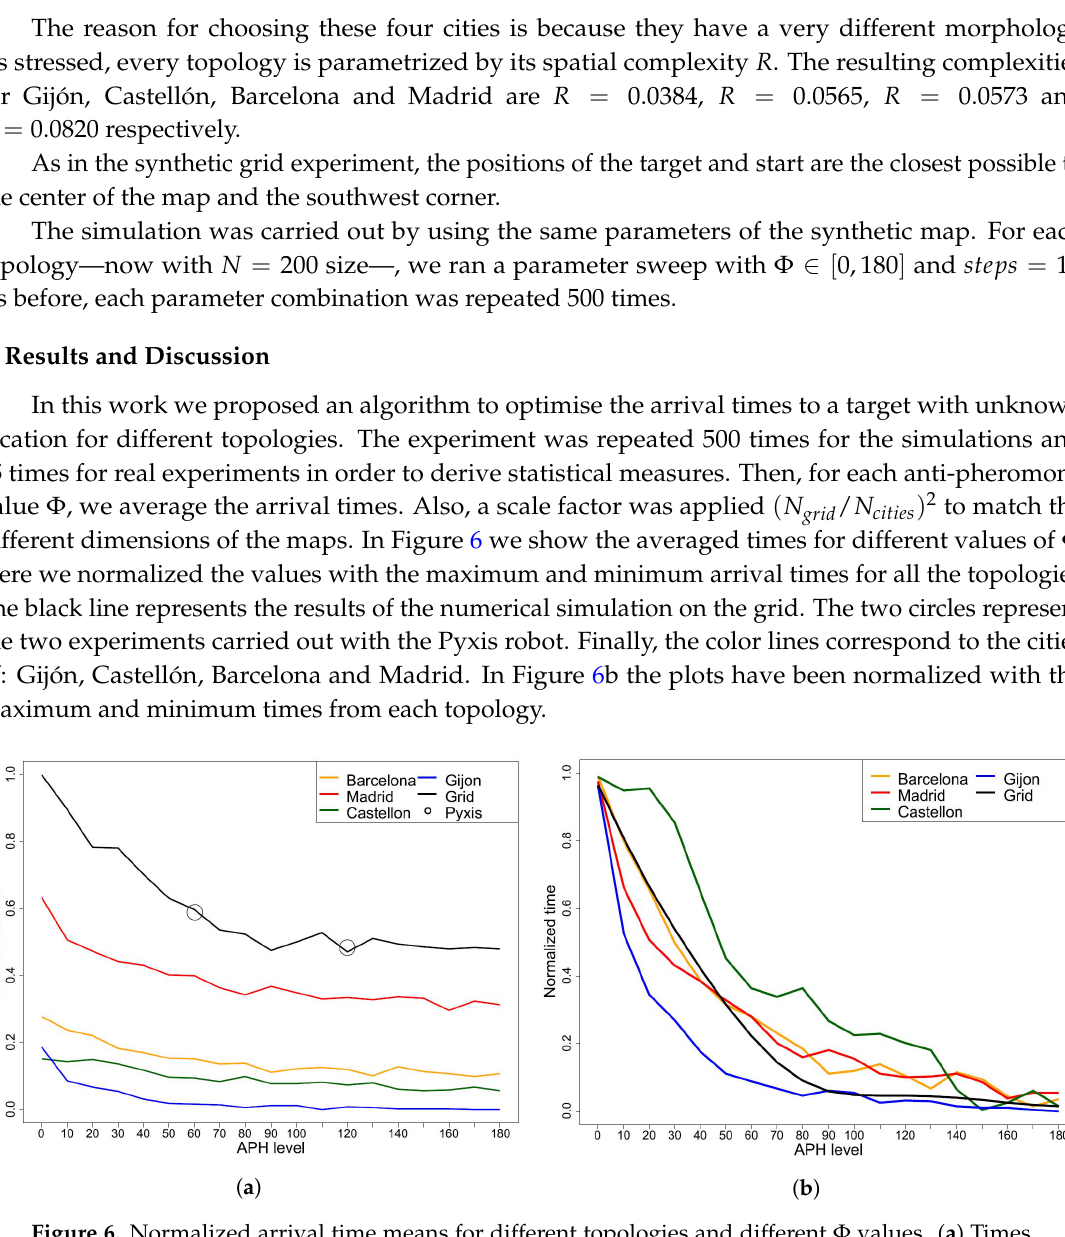
Figure 6. Normalized arrival time means for different topologies and different Φ values. ( a ) Times are first scaled with the city to grid area ratio and then normalized with the maximum and minimum values obtained from all topologies; ( b ) times are normalized with the maximum and minimum times from each